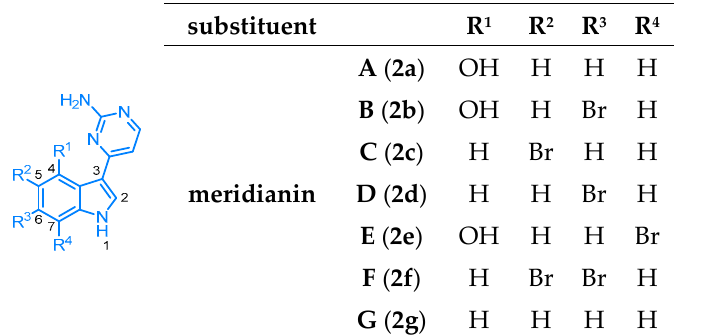
Figure 2. Meridianins 2 isolated from the tunicate Aplidium meridianum [9,10].